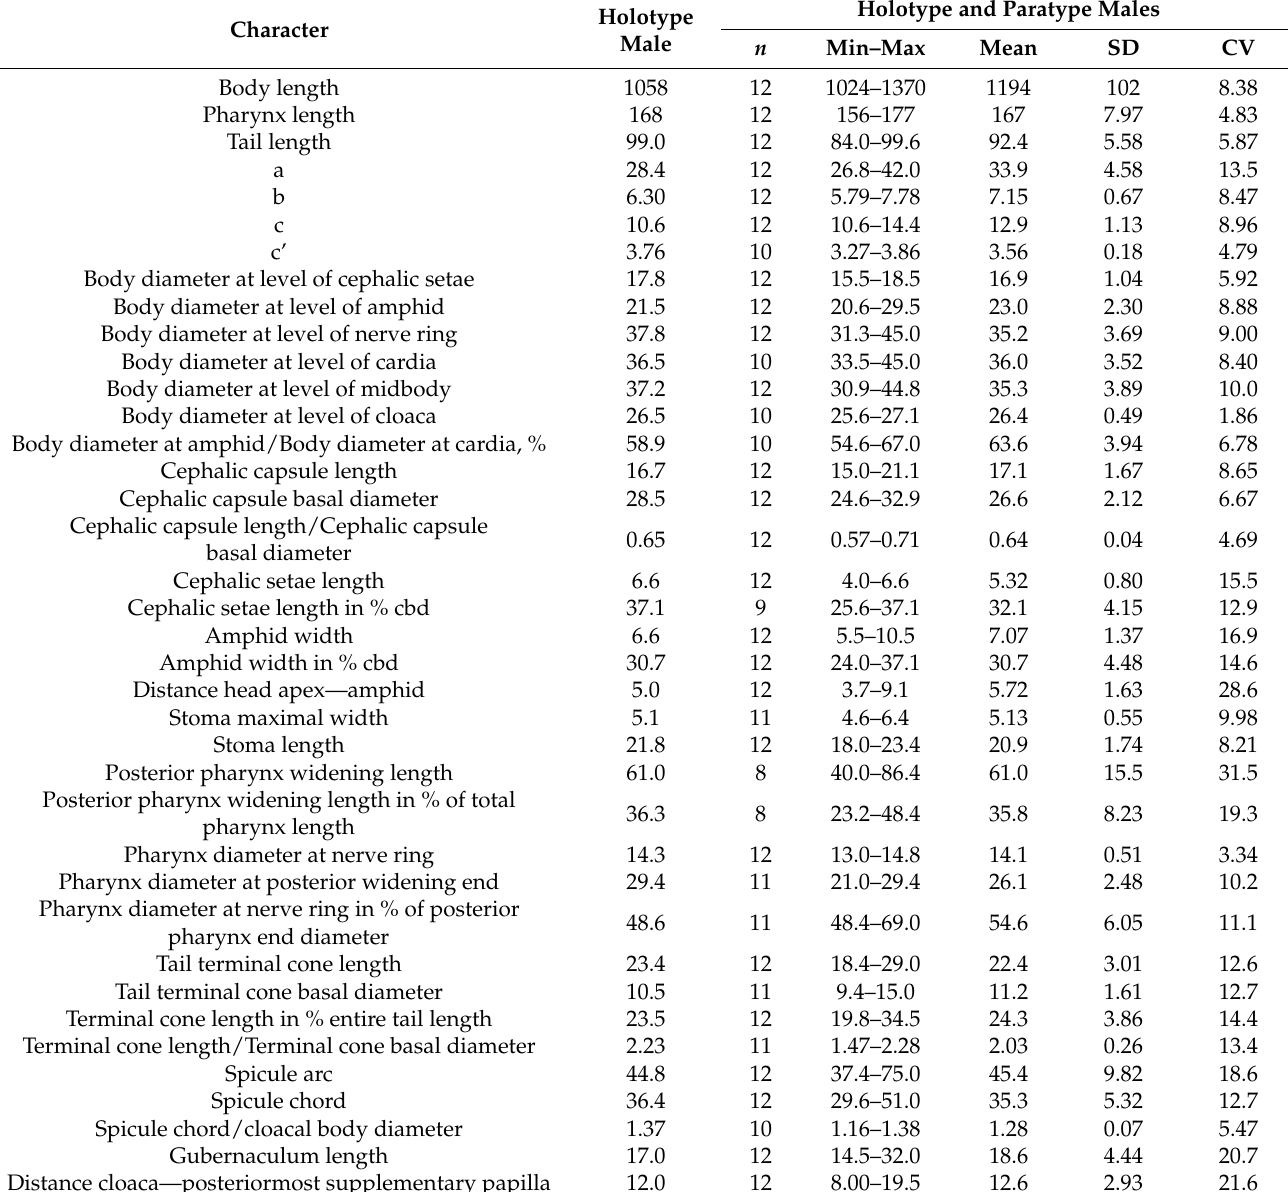
Table 7. Morphometrics of males Acanthopharynx parva sp. n. from samples PA13 and PA21 united.